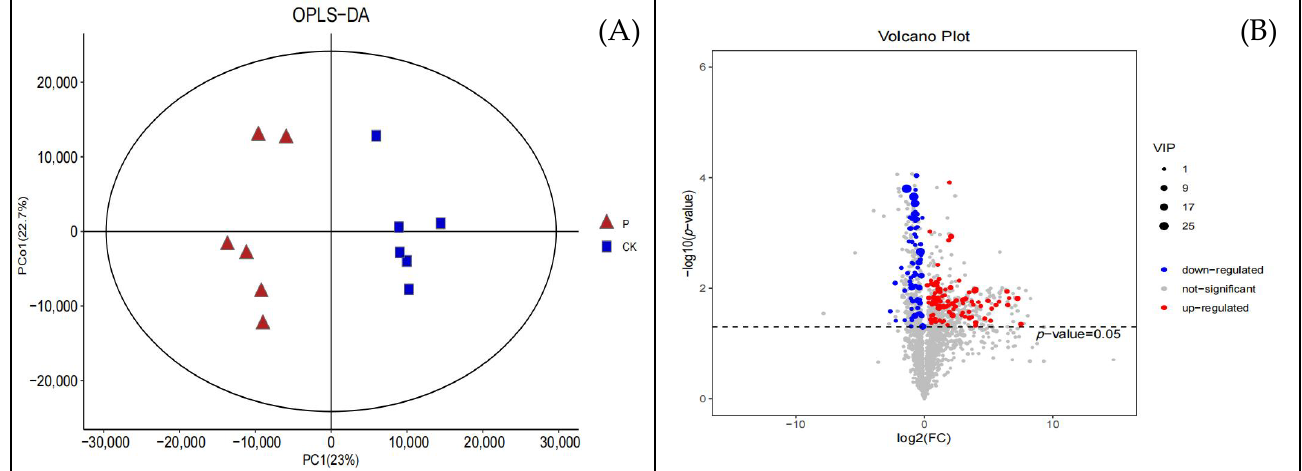
Figure 3. ( A ) Principal component analysis (PCA) of the variance-stabilized estimated raw counts of DAMs. ( B ) Volcano plot of DAMs between CK and P. The green dots represent downregulated DAMs, the red dots represent upregulated DAMs, and the gray dots represent insignificant DAMs. DAMs, differentially accumulated metabolites; FC, fold change; CK, no Pga inoculation; P, Pga inoculation.